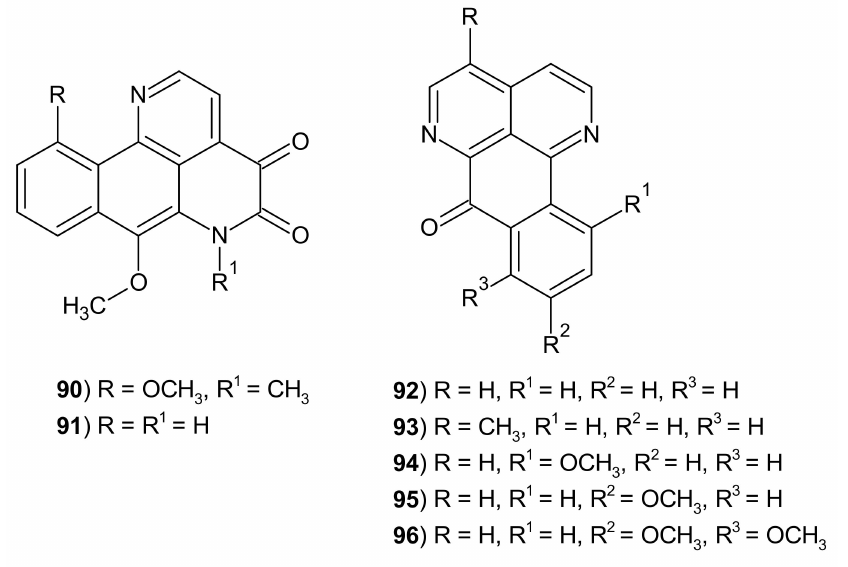
Figure 27. Hadrantines A 90 and hadranthine B 91, and sampangines 92 – 96 . Hadranthine A (7,10-dimethoxy-6-methyl-4,5-dihydronaphthol[1,2,3- ij ][2,7] naphthyr- idine-4,5-(6 H )-dione) 90 showed in vitro antimalarial activity against chloroquine-resistant P. falciparum with IC50 = 120 ng/mL. This alkaloid was active against C. albicans with MIC = 20 µ g/mL. Hadranthine B (7-methoxy-4,5-dihydronaphthol[1,2,3- ij ][2,7]naphthyri- dine-4,5-(6 H )-dione) 91 did not show antimalarial activity, but it exhibited in vitro cytotoxic activity against human malignant melanoma, epidermoid carcinoma, ductal carcinoma, and ovary carcinoma cell lines with IC 50 values between 3–6 µ g/mL [113]. This alkaloid 91 was also evaluated for its in vitro effects on immune response and inflammation, but did not show significant potency